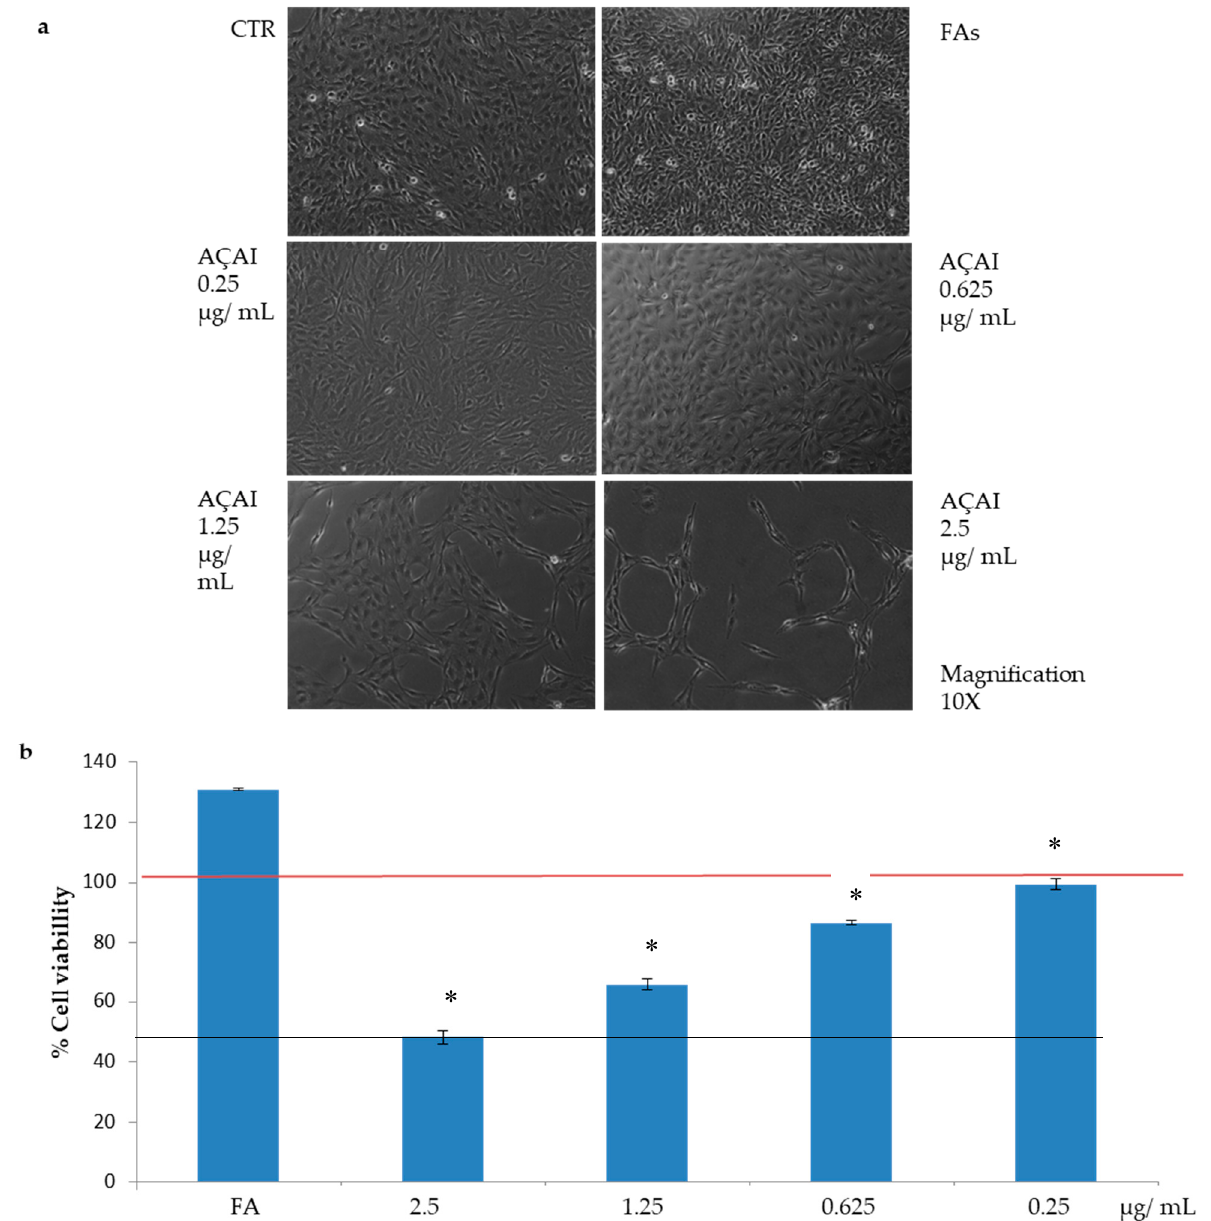
Figure 2. Viability of steatotic HepG2 cells in the presence of açai extract. After 24 h of FAs incubation, cells were treated with increasing concentrations of açai extract (from 0.25 to 2.5 µ g/mL) for other 24 h. ( a ) Images of cells obtained by optical microscopy, 10 × magnification; ( b ) Viability, assessed by Presto Blue reagent, is expressed as percentage with respect to untreated cells (indicated by the red line). The black line indicates the 50% of cell viability. * p < 0.05 for all the acaj added samples vs FA. Treatment with 0.25 µ g/mL acaj extract proved the same cell viability than untreated control. Only 2.5 µ g/mL treatment reduced viability of 50% respect to control, showing a certain cytotoxicity.